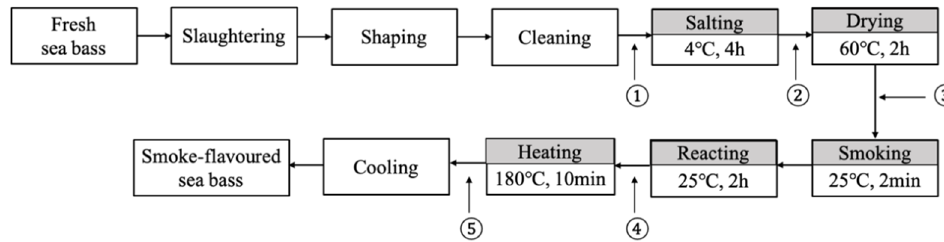
Figure 1. Schematic diagram of smoke-flavored sea bass processing line and five sampling points. Sampling point 1: fresh fish fillet; Sampling point 2: salting; Sampling point 3: drying; Sampling point 4: smoking; Sampling point 5: heating.